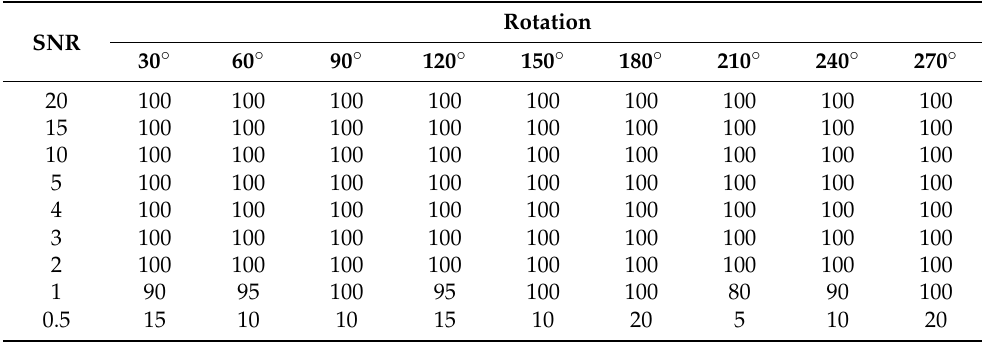
Table 10. The correct recognition rates for a combination of rotation angles and noise levels for the proposed method for the 2D aircraft dataset.